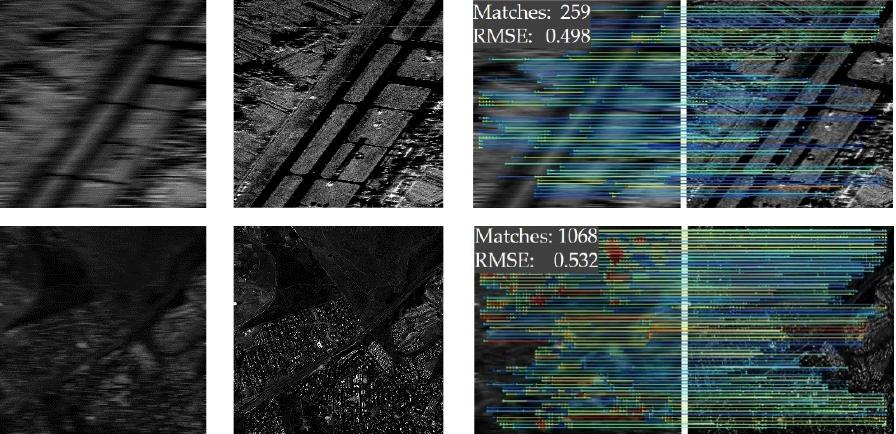
Figure 14. Algorithm robustness test in a noise scenario.